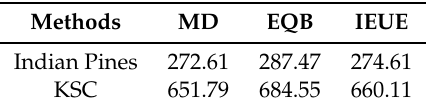
Table 7. CPU processing time (in seconds) of different AL selection methods for the Indian Pines and KSC